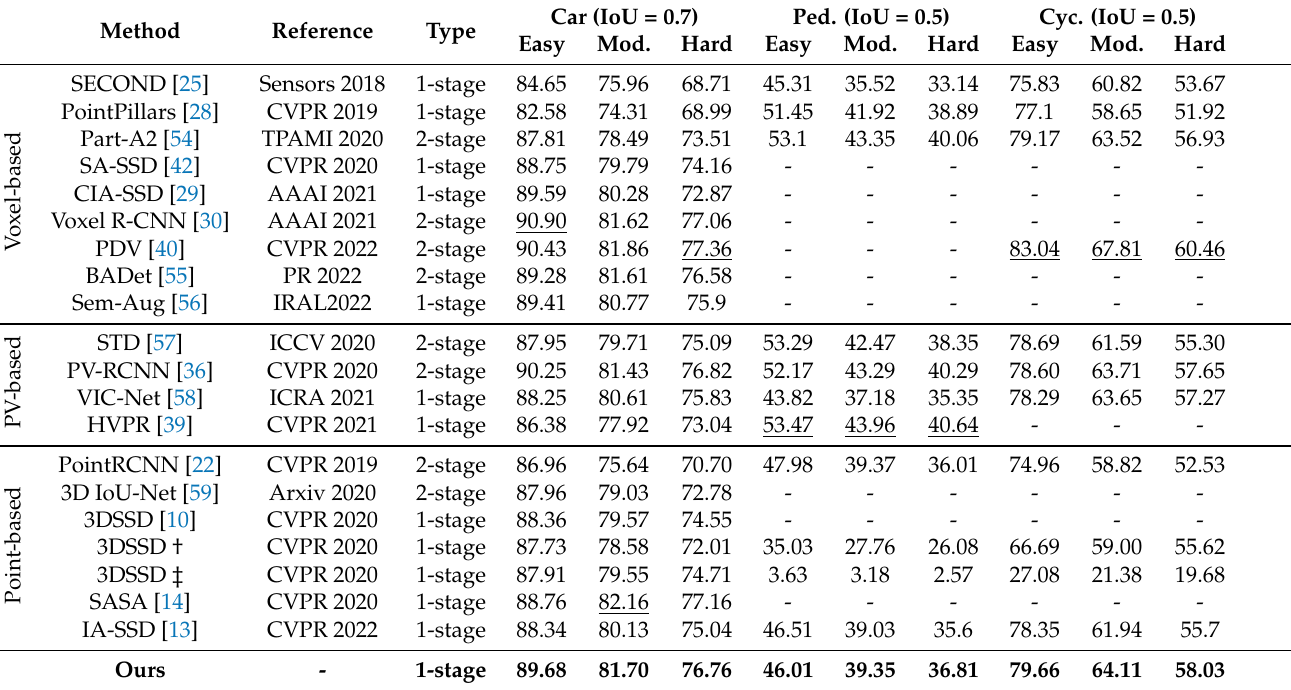
Table 1. Quantitative detection performance achieved by different methods on the KITTI test set. The results of our SGSSD are shown in bold, and the best results are underlined.